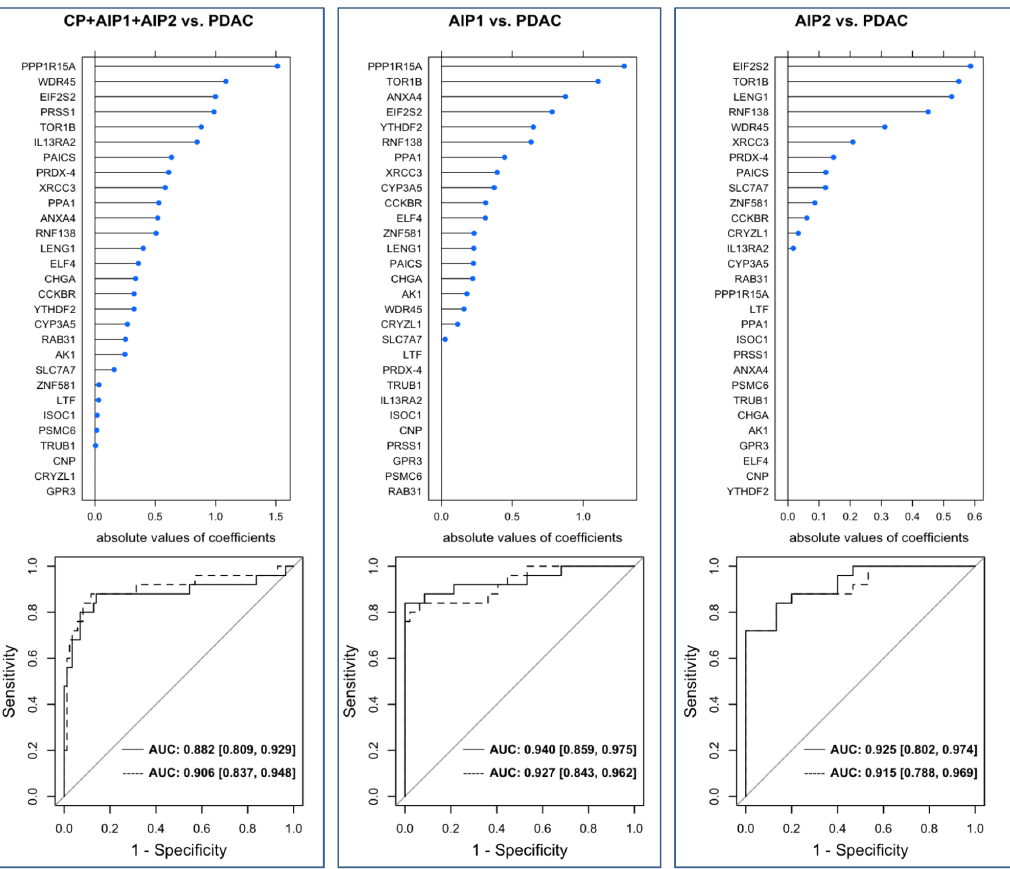
Figure 4. The predictive performance of the models. Upper graphs present the variable importance measured as mean absolute values of the coe ffi cients estimated during cross-validation of the models incorporating the 29 identified antigens. Below, corresponding ROC curves of the statistical models discriminating between AIP-1 + AIP-2 + CP vs. PDAC ( left ), AIP-1 vs. PDAC ( middle ), and AIP-2 vs. PDAC ( right ). The ROC curves for the models based on the 29 antigens are depicted as continuous lines and the ROC curves for the models based on the 36 antigens as dashed lines. The corresponding confidence intervals of the AUC values are indicated in the square brackets. Confidence intervals for the AUC values were computed by the formula according to Wilson [19].